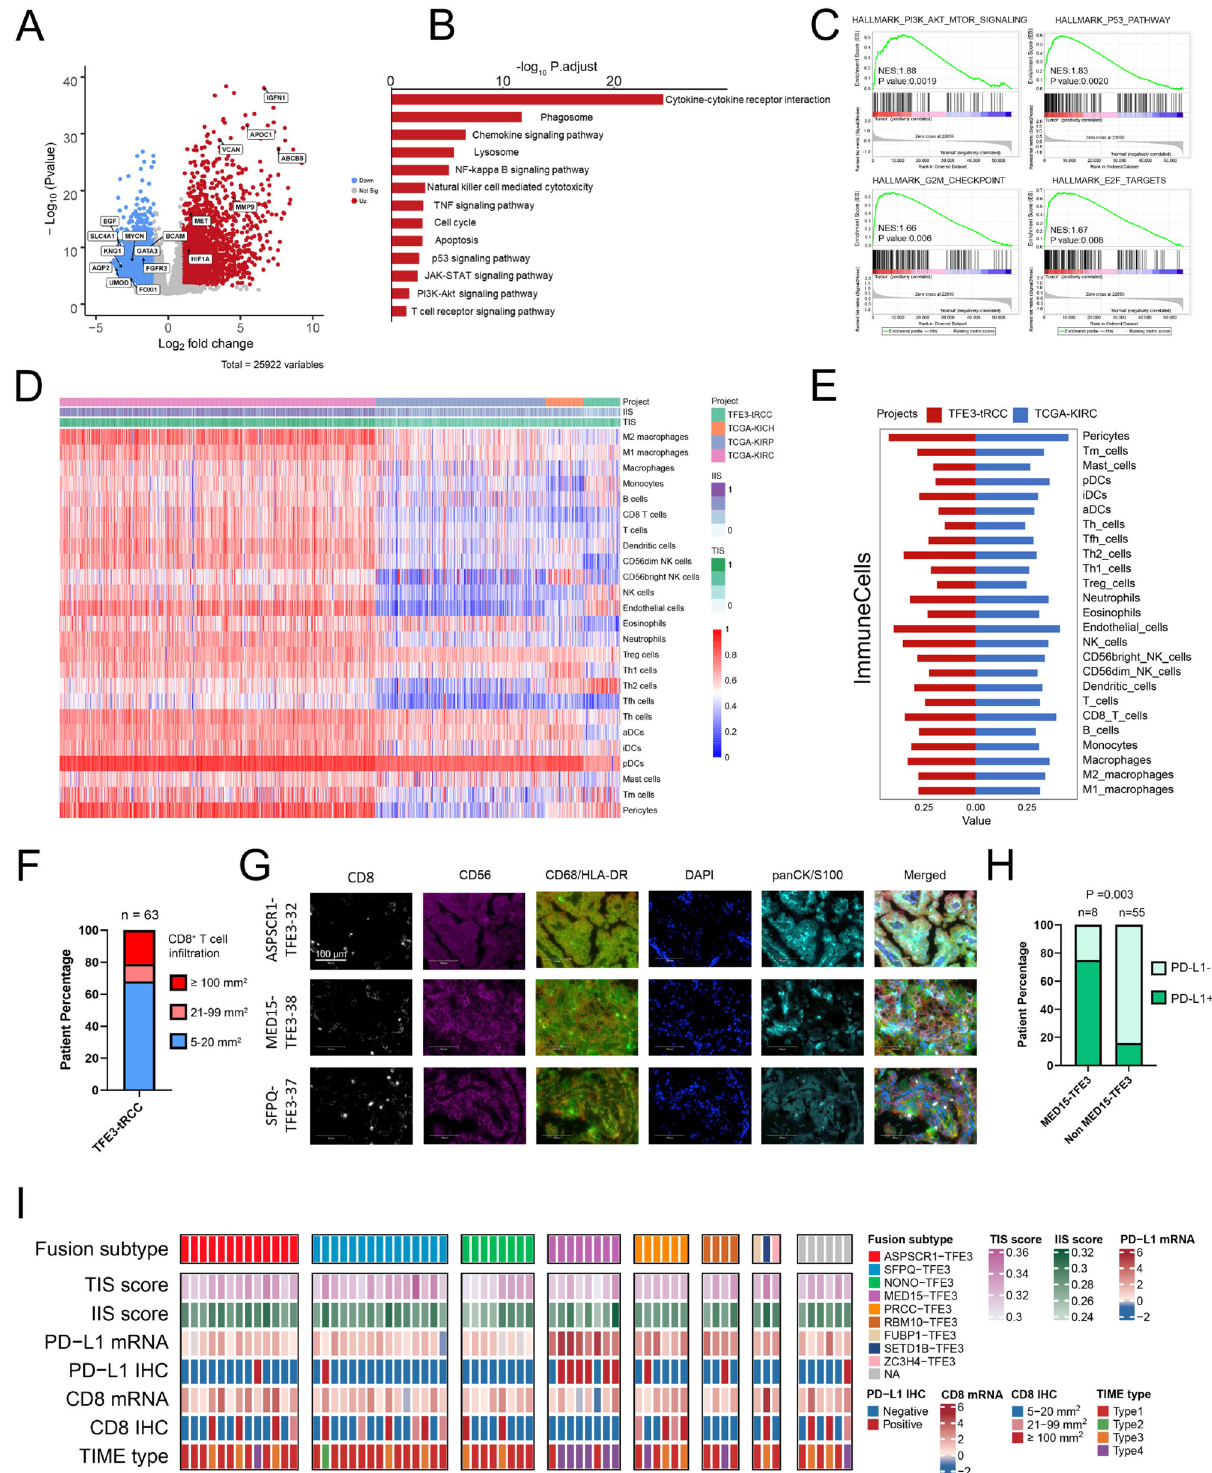
different from the RNA-seq results, there was a relatively low PD- L1 positivity rate (17.5%, 11/63) in our TFE3 -tRCC cohort as assessed via PD-L1 IHC staining. Interestingly, we observed higher expression of PD-L1 mRNA and protein levels in tumors with MED15 - TFE3 fusion (Fig. 4H and Supplementary Figure 8D). Apart from MED15 - TFE3 fusion tRCC, nearly two-thirds (63.5%, 40/63) of TFE3 -tRCCs in our cohort exhibited type 1 TIME 19 , characterized by a low CD8 + T-cells in fi ltration and